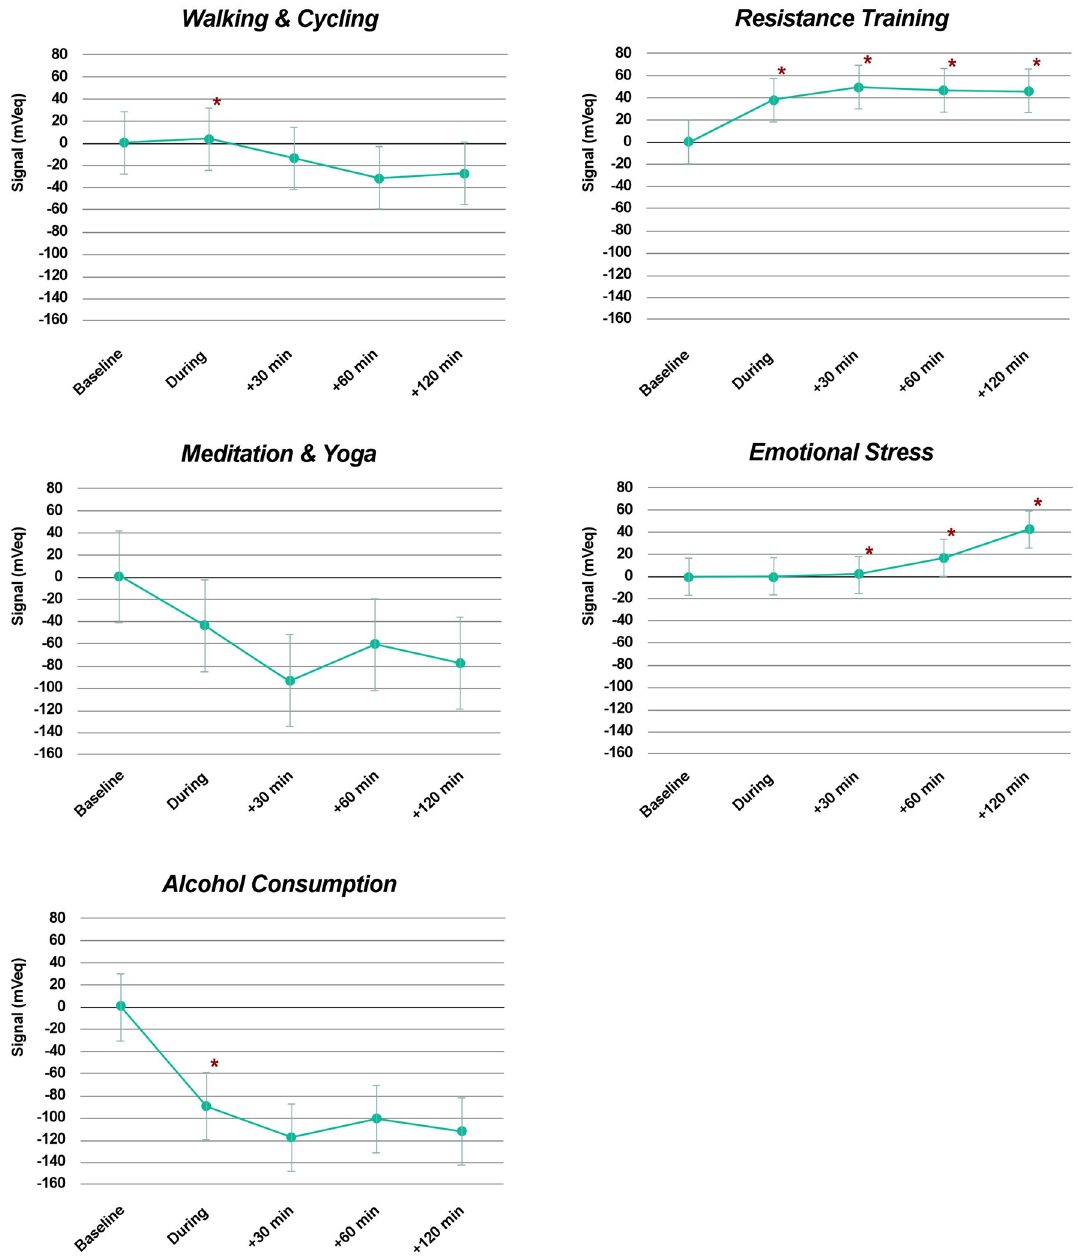
Figure 1. Mean effect of each group of activities on intraocular pressure-related signal recorded in mVeq, during the event, within 30 min of the end of the event, between 30 and 60 min of the end of the event, and between 90 and 120 min of the end of the event, compared to baseline measurements set at 0 mVeq (30–60 min before the start of the event). Vertical bars represent the 95% confidence interval, and asterisks represent statistically significant differences from baseline ( p <